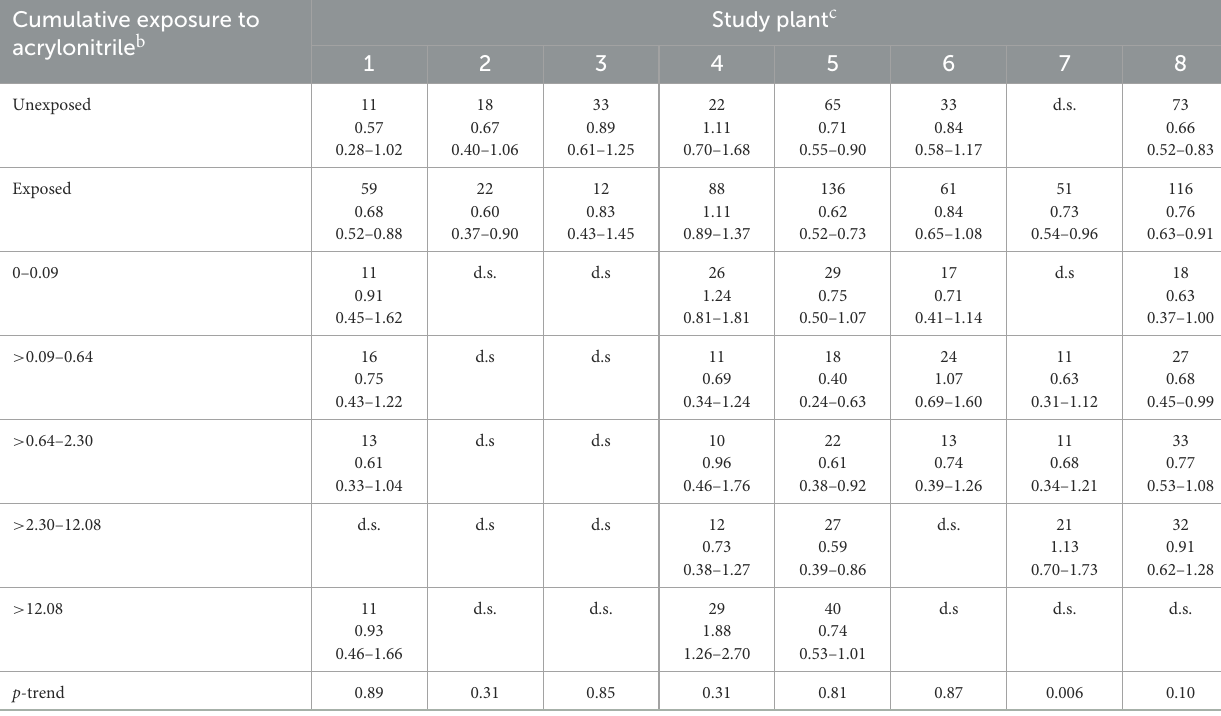
TABLE 3 Observed deaths and UPitt external rate-based SMRs a (regional rates) and 95% CIs for lung and bronchus cancer by cumulative acrylonitrile exposure category (lagged by 10 years) and study plant, full cohort, in the follow-up period 1942–2011. Cumulative exposure to acrylonitrile b